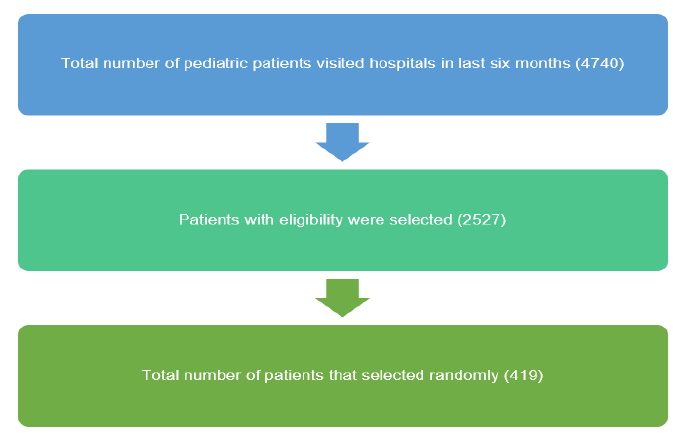
Figure 1. The sample size of pediatric patients.